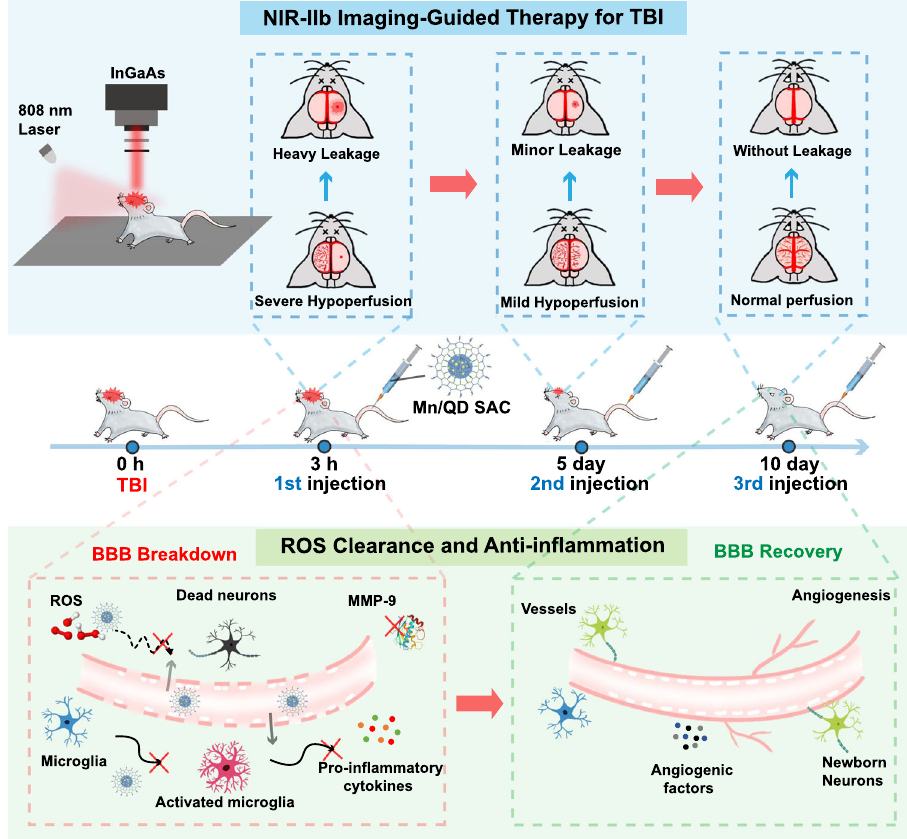
Fig.1|SchematicdiagramofMn/QDsingle-atomcatalystforimaging-guidedTBItherapy. Thenear-infrared-IIbemittingMnsingle-atomcatalystenablesdynamically monitoring the BBB status in a noninvasive way and repressing the ROS-mediated BBB